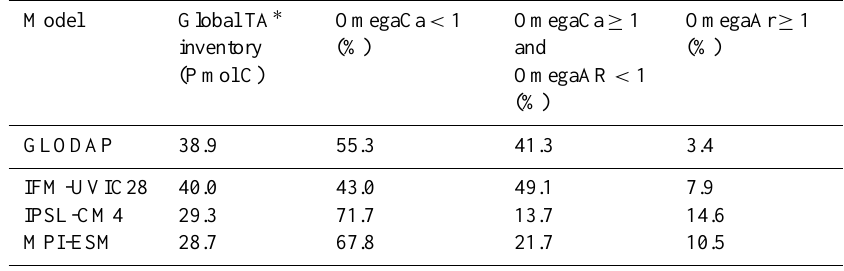
Table 4. Global TA ∗ inventories (PmolC) and its fractions with respect to the CaCO 3 saturation states.